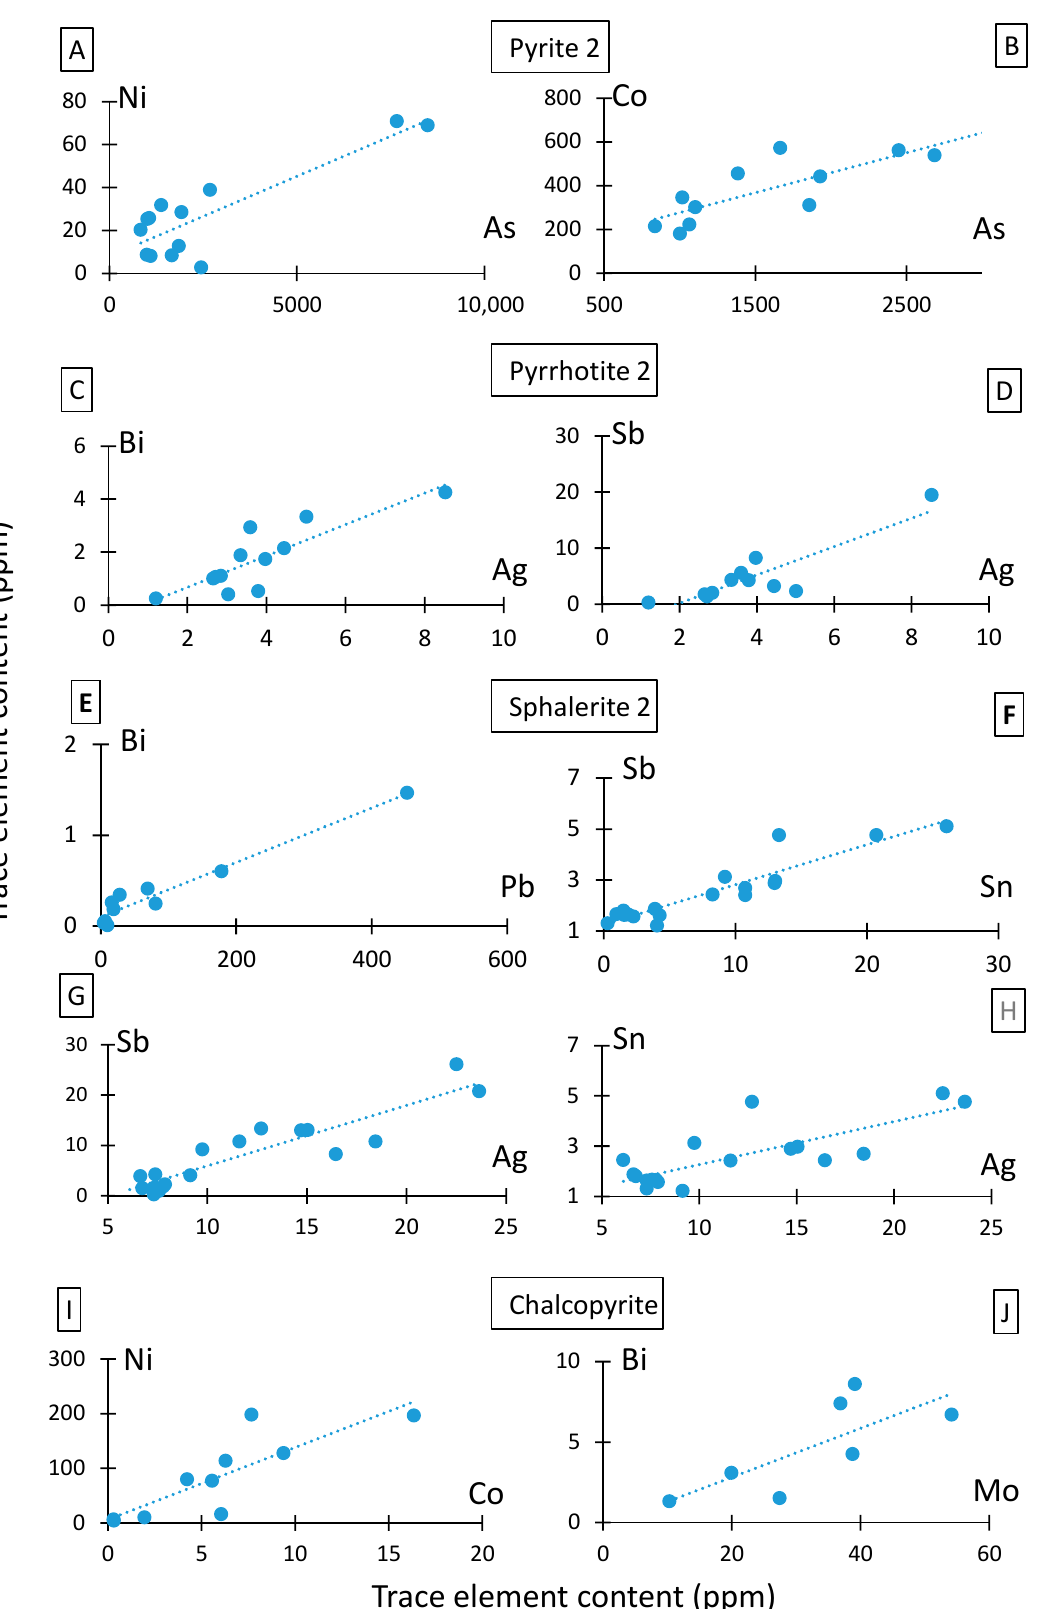
Figure 4. Correlation of trace elements detected using LA-ICP-MS analysis in major minerals from Koudiat Aïcha (from stage II: pyrite 2, pyrrhotite 2 and sphalerite 2; from stage III: chalcopyrite). Data are in ppm. Stage II. ( A , B ) Pyrite 2, ( C , D ) Pyrrhotite 2, ( E – H ) Sphalerite 2; Stage III: ( I , J )